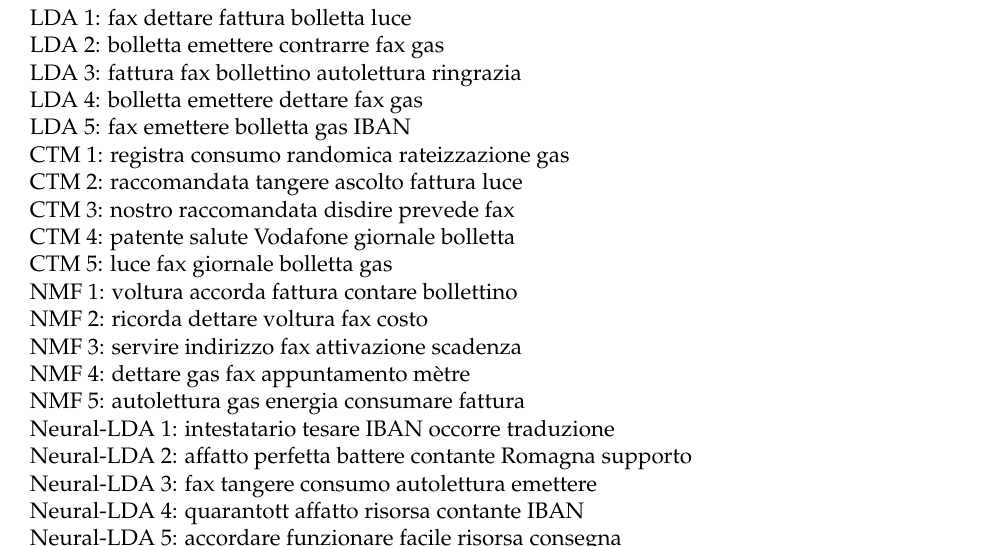
Table 3. Top ten words for five topics, using k = 25.